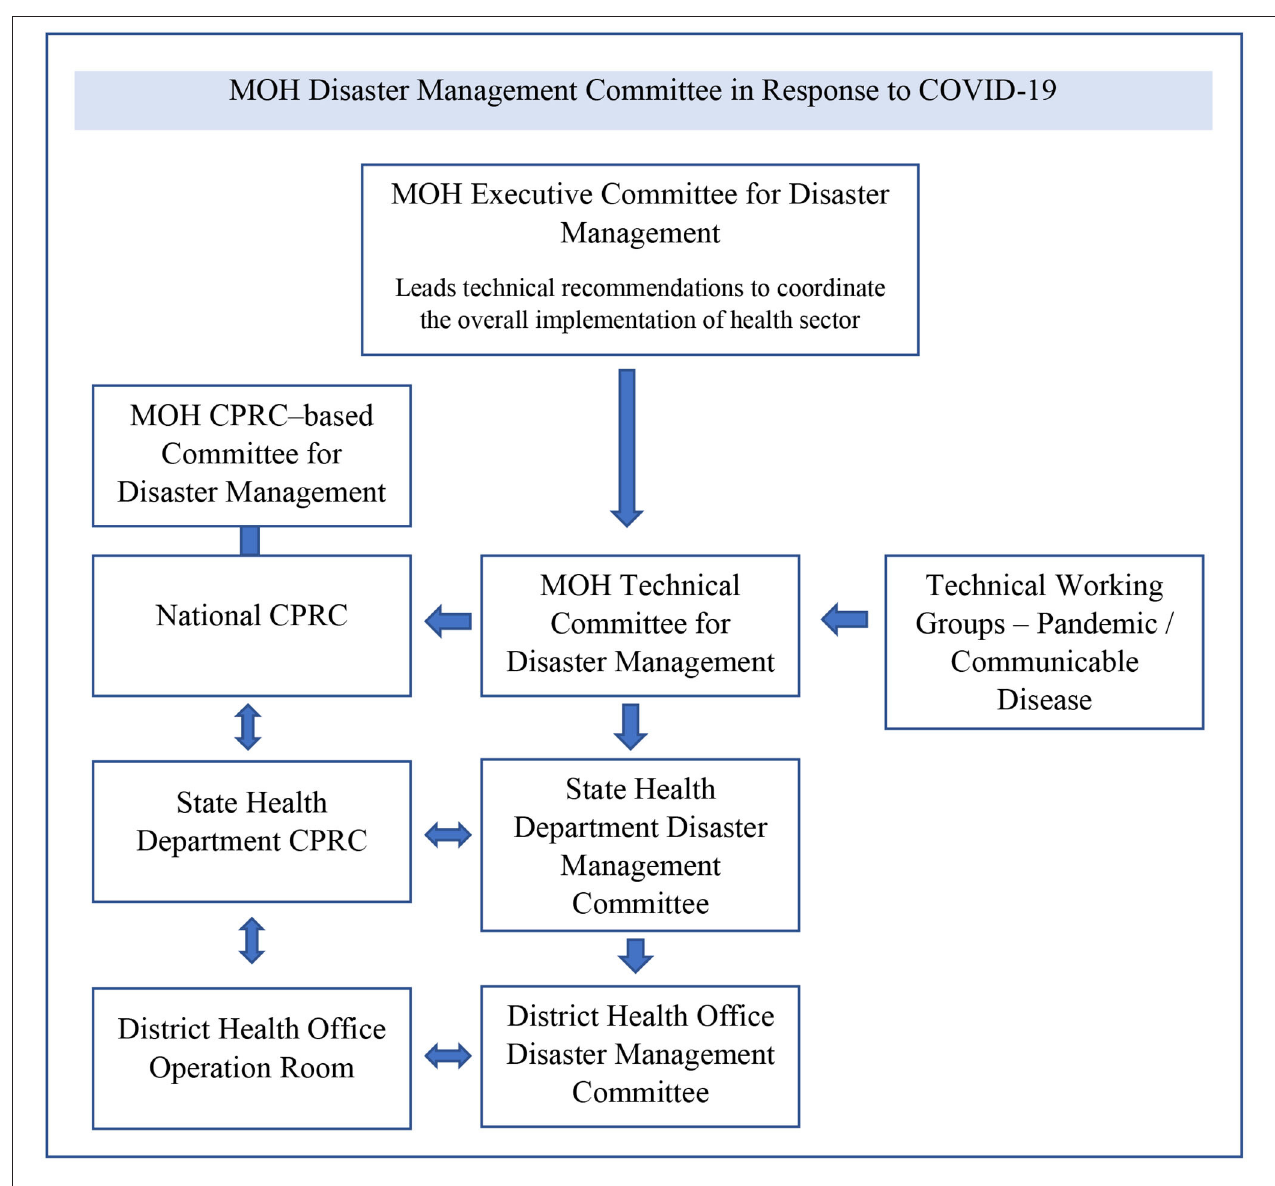
FIGURE 1 | MOH disaster management committee in response to COVID-19. (Source: MOH, MOH Disaster Response Plan,